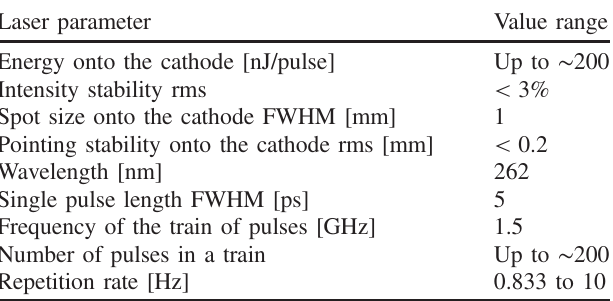
TABLE I. Photo-injector laser parameters.